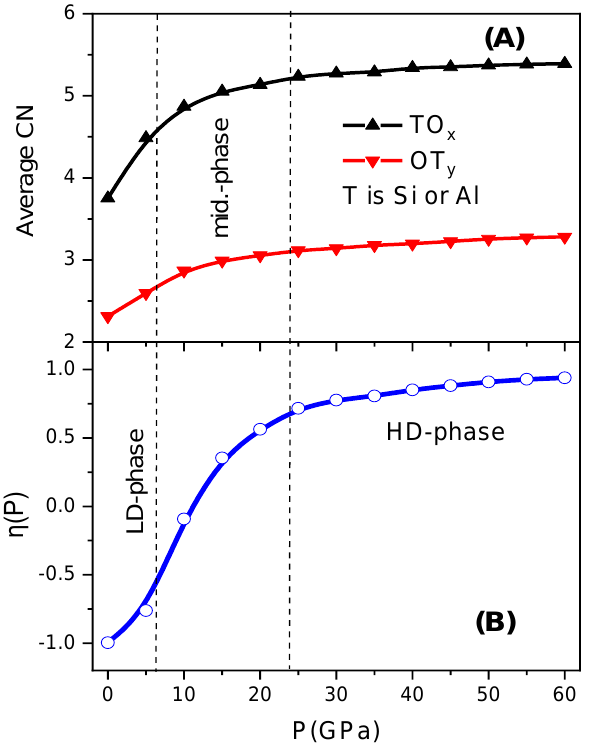
Figure 7. Panel A displays the evolution of average coordination number (CN) as a function of pressure. Panel B shows the pressure dependence of the order parameter η of the AS2 model at different pressures According to Figure 8, largest fraction C x for 0-6, 6-24, 24-60 GPa intervals is fraction C TO4 , C TO5 and C TO6 , respectively. This implies that large phases for those intervals are LD-phase, LD- and HD-phases, and HD-phases, respectively. Thus, the structure of AS2 glass undergoes through three pressure regions, corresponding with existence of LD-phase, LD-, and HD-phases implied the polymorphism of AS2